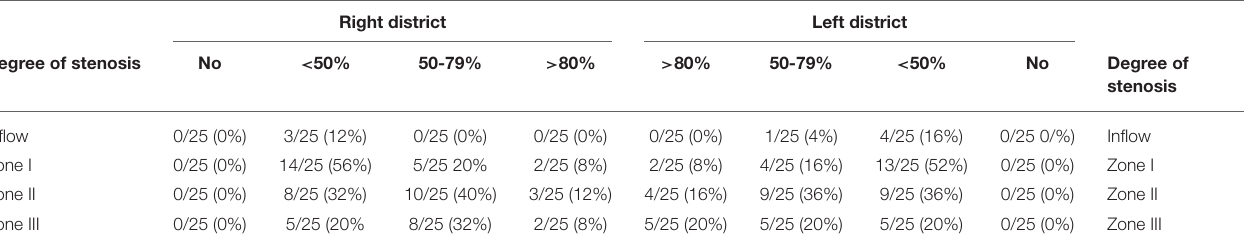
TABLE 3 | Anatomical localization of steno-occlusive disease of pelvic arterial tree following the “MAPPING AND SCORING SHEET” grading. Right district Left